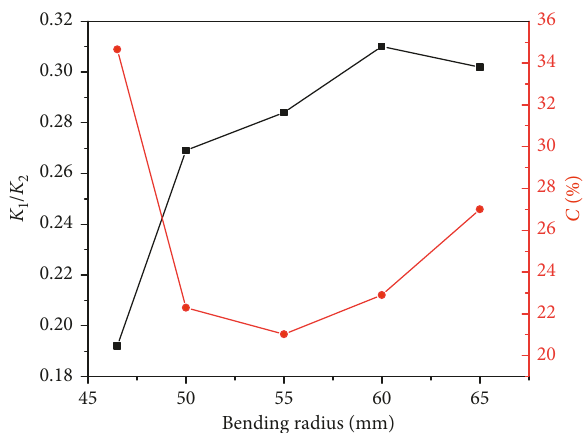
Figure 12: The stiffness-damping characteristics of the GGQ-99 WRI with different bending radii of the wire rope. Table 7. By using the MATLAB software, equations (5) and (6) were formulated fitting with the corresponding structural parameters, respectively.